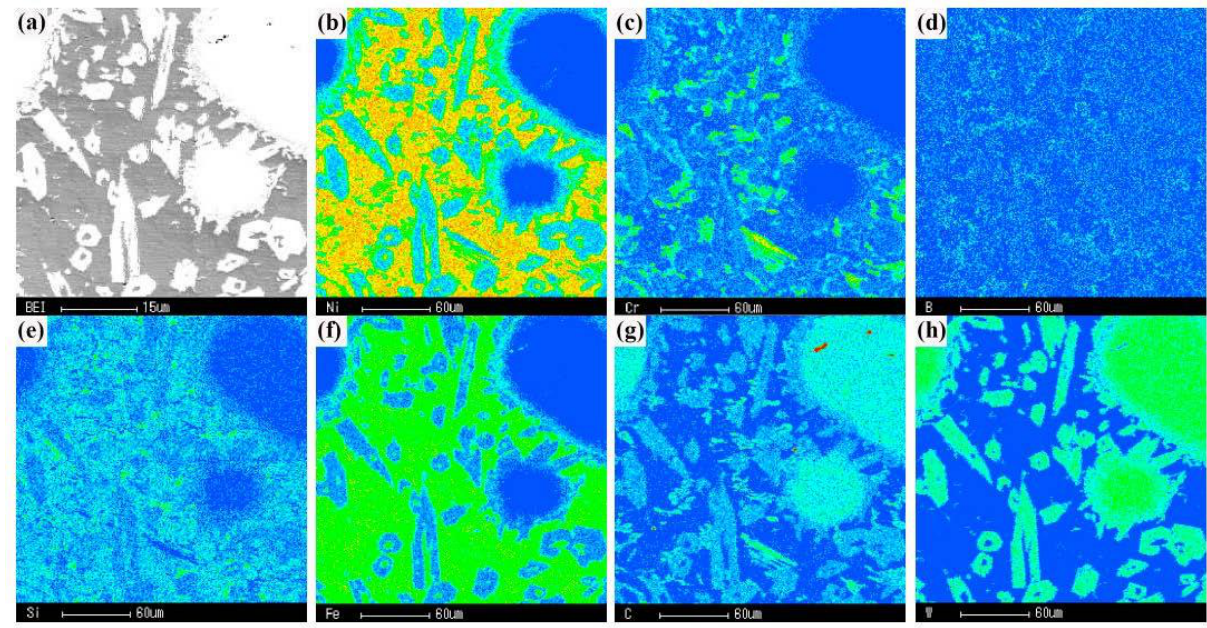
Figure 8. SEM ( a ) and BSE ( b ) images of the sample D.